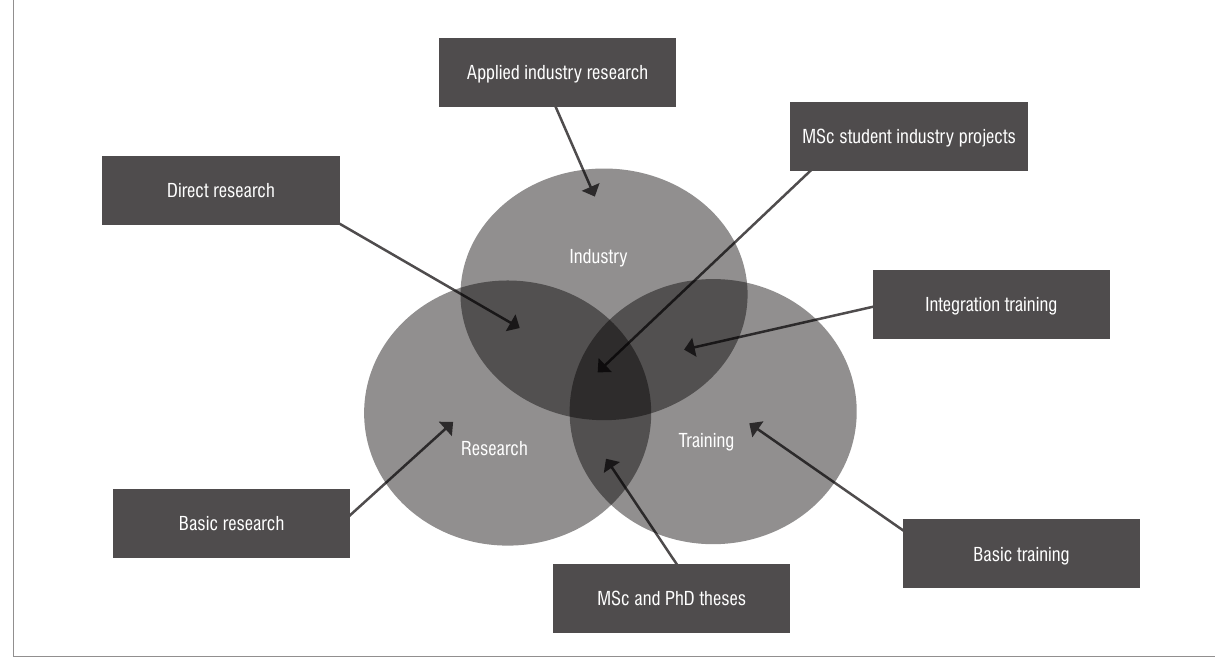
The design concept for implementation of the